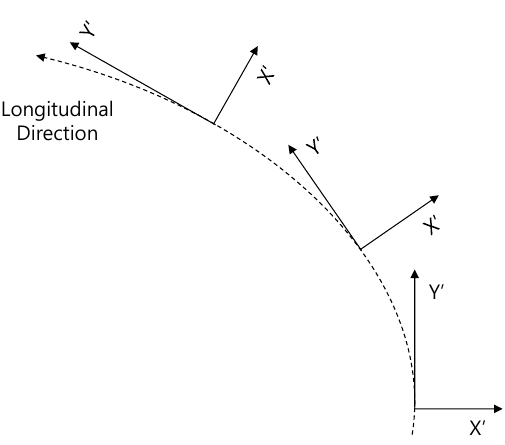
Figure 3. Definition of a coordinate system used in this study.